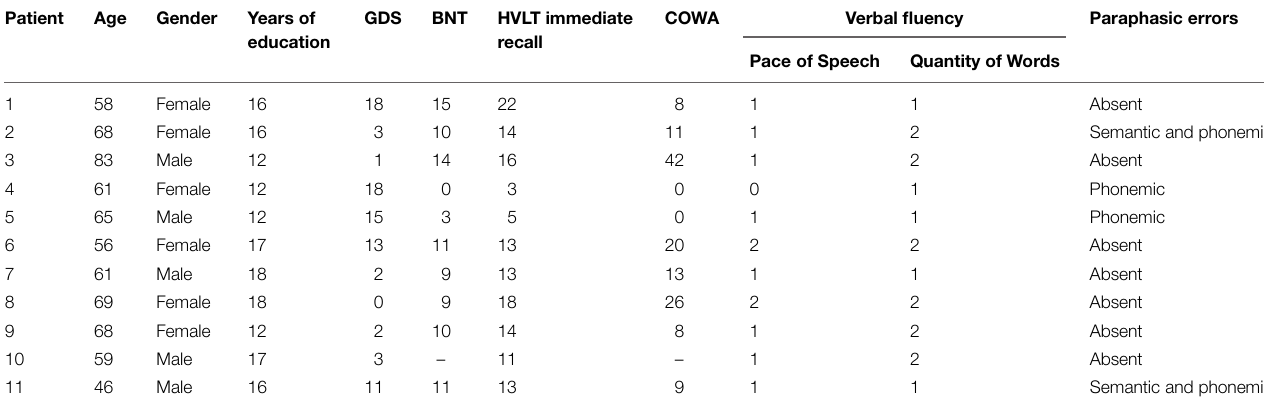
TABLE 1 | Psychometric and neurological data on the current patient sample.